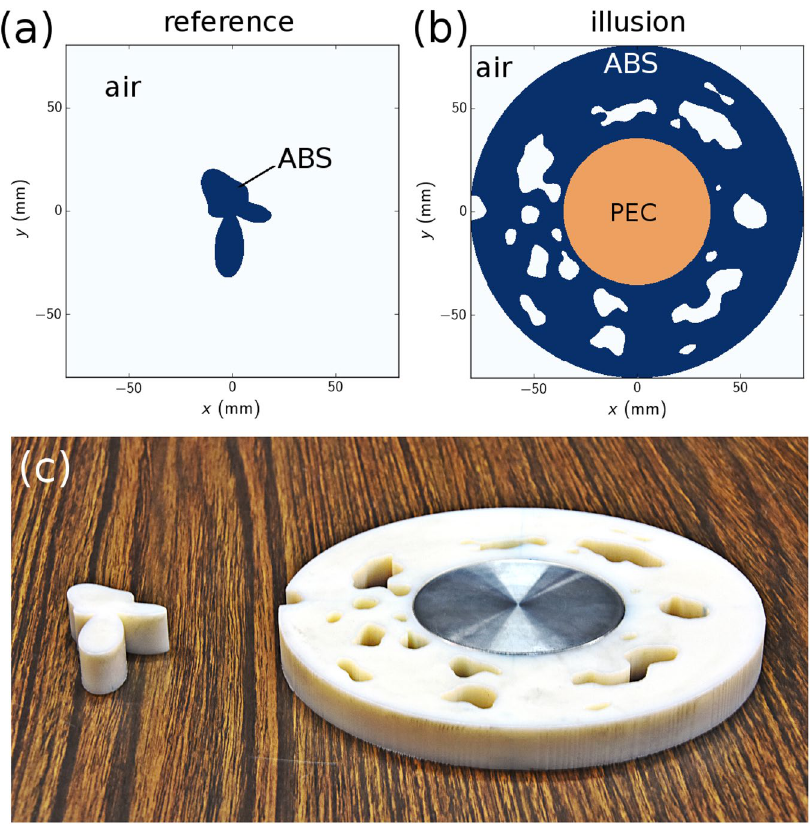
Figure 1. Optimization results. ( a ) Reference dielectric object. ( b ) Optimized illusion device. ( c ) Photograph of the 3D printed